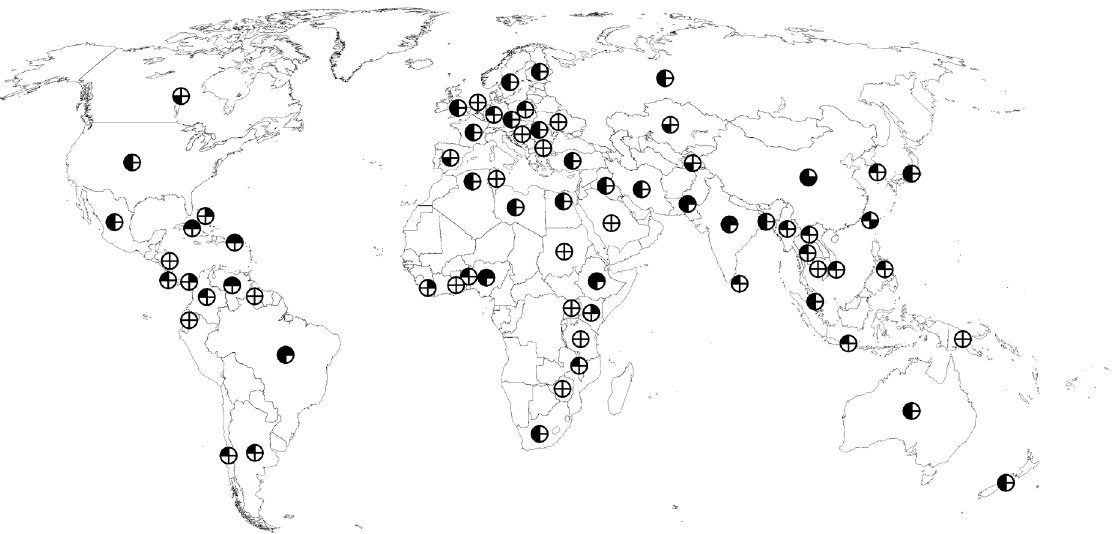
Fig. 2. Geographical distribution of four species of ischnoceran chewing lice parasitizing wild and domestic chicken ( Gallus spp.). Each circle is divided into four sectors, representing the four louse species: upper left = Lipeurus caponis (Linnaeus, 1758); upper right = Lipeurus tropicalis Peters, 1931; lower left = Cuclotogaster heterographus (Nitzsch, 1866); lower right = Lagopoecus sinensis (Sugimoto, 1930). Black sectors indicate that this louse species is known from this country, whereas hollow sectors indicate that we have found no published records of this species in this country. Presence of the four species of chewing lice in a country is based on the reports summarized in Table